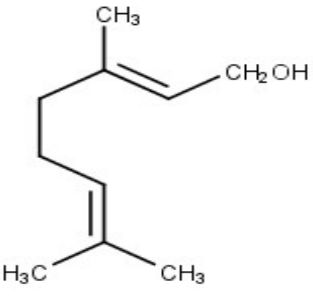
Figure 1. Chemical structure of geraniol.